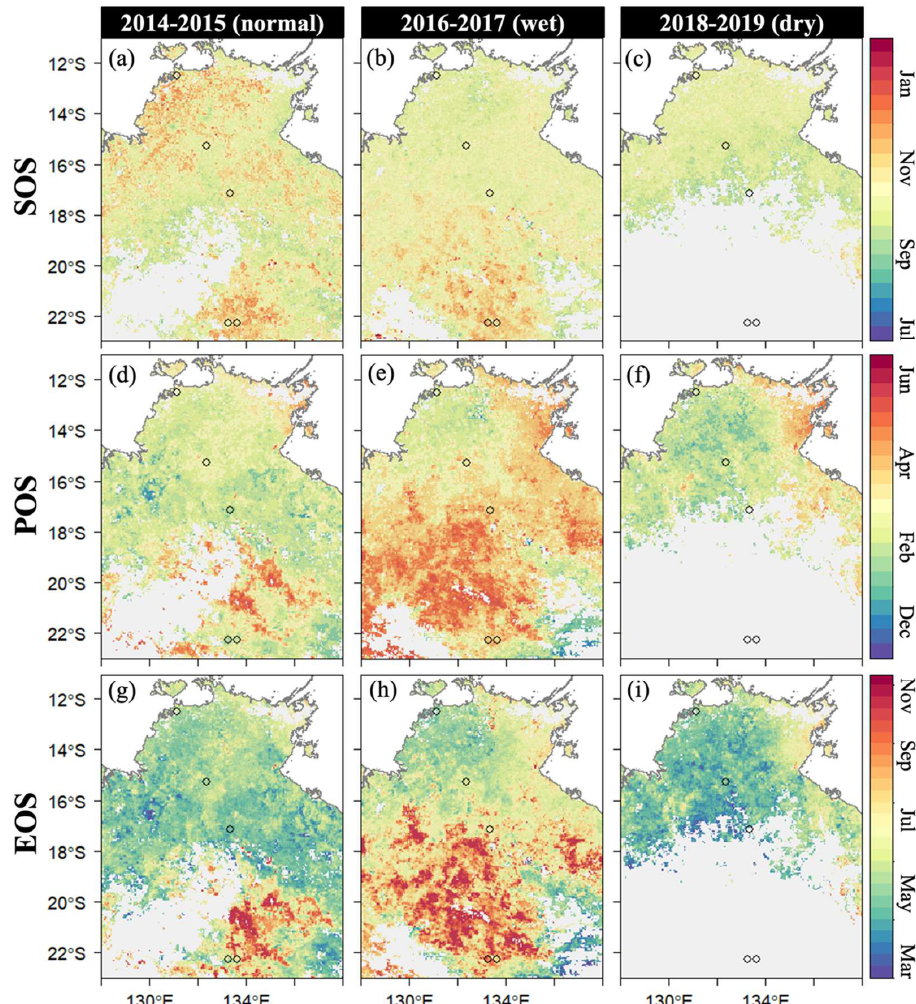
Figure 5. Spatial patterns of vegetation phenology based on EVI over the NATT study area across three representative hydrological years, ( a , d , g ) 2014–2015 (normal year), ( b , e , h ) 2016–2017 (wet year), and ( c , f , i ) 2018–2019 (dry year). The filled pixels (grey shaded areas) are either water body or without detectable phenology. SOS: the start of growing season; POS: the peak of growing season; EOS: the end of growing season. Blank circles represent 5 selected eddy covariance flux tower sites.